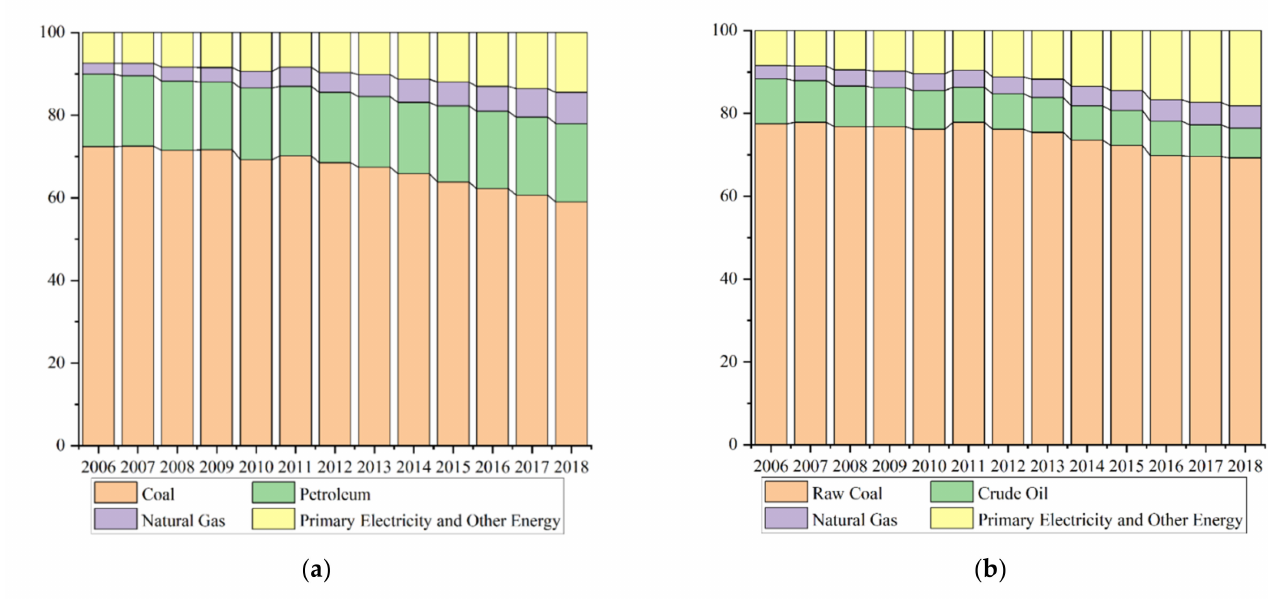
Figure 1. The energy structure in China. Note: the figure shows that China’s energy consumption structure and energy production structure were gradually optimized from 2006 to 2018. The share of fossil energy in China is over 80%, both on the production side and the consumption side. ( a ) Energy Consumption Structure. ( b ) Energy Production